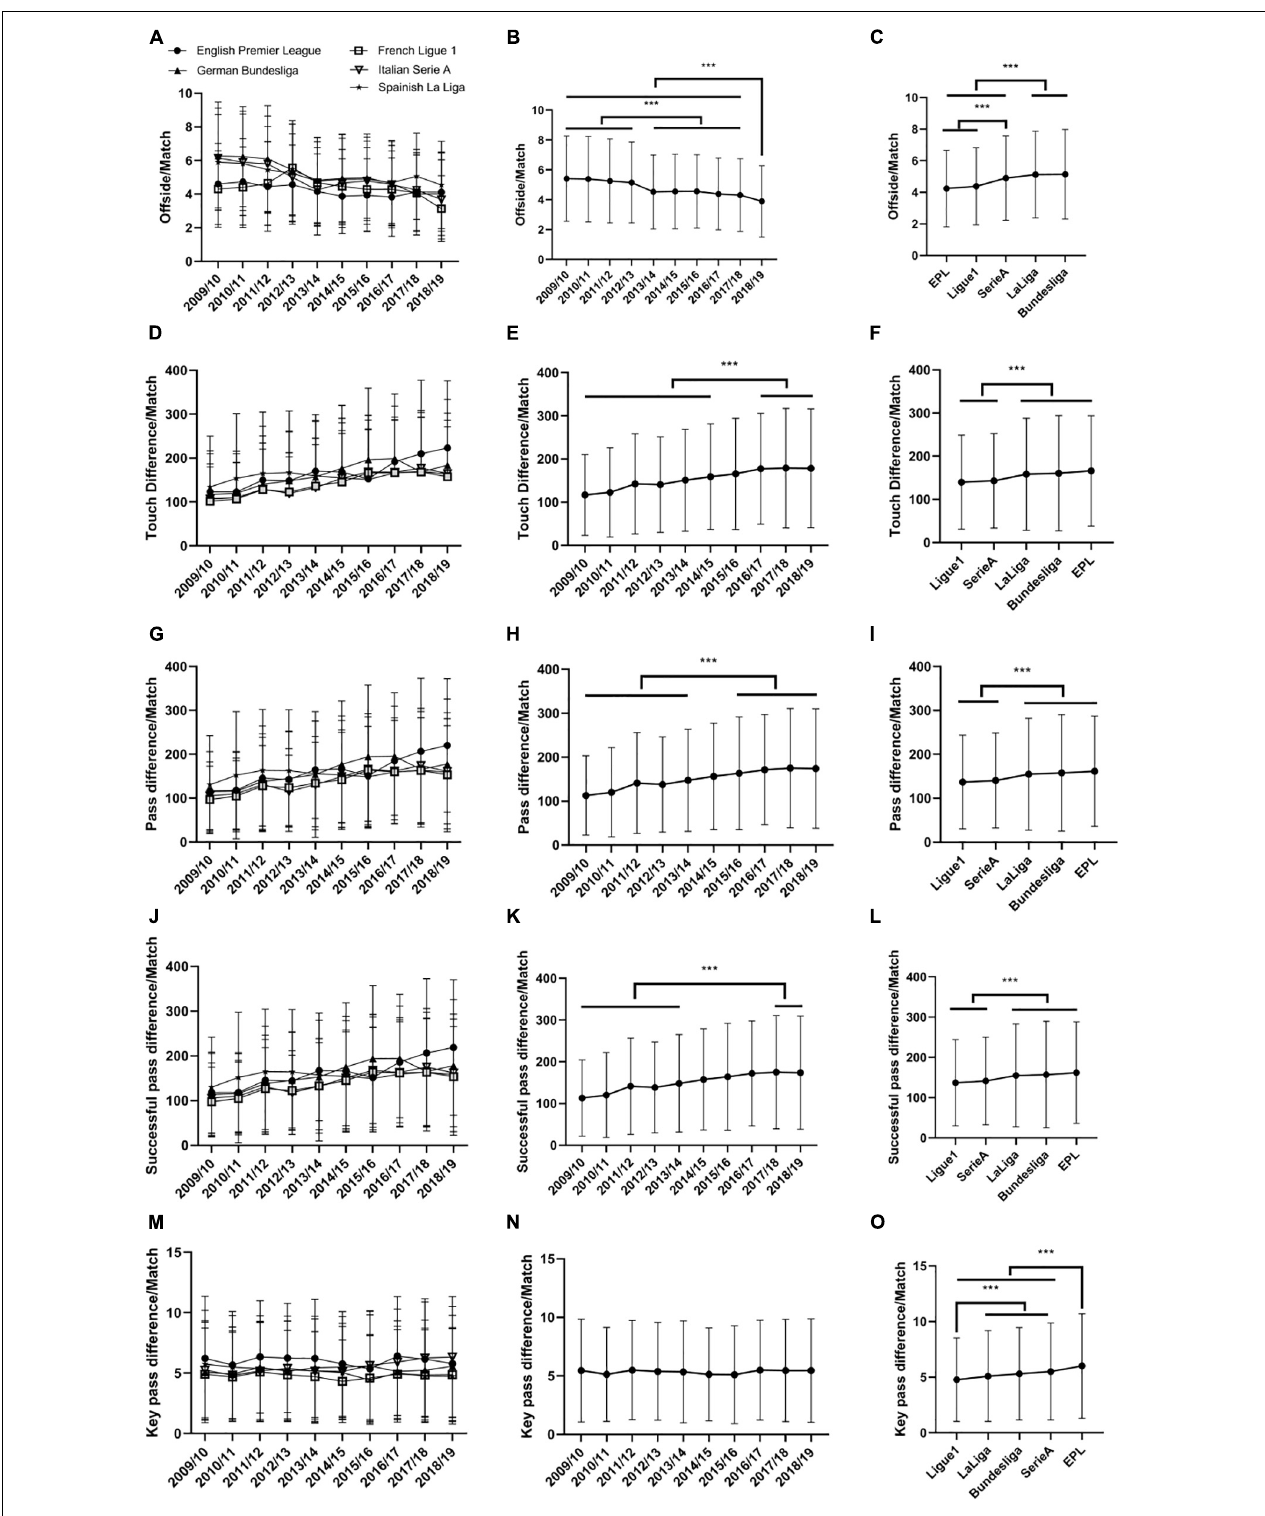
FIGURE 2 | (A) Offsides per match, (D) touch difference per match, (G) pass difference per match, (J) successful pass difference per match, (M) and key pass difference per match for each league over the ten seasons span. (B) Offsides per match, (E) touch difference per match, (H) pass difference per match, (K) successful pass difference per match, (N) and key pass difference per match for each season. (C) Offsides per match, (F) touch difference per match, (I) pass difference per match, (L) successful pass difference per match, (O) and key pass difference per match for each league. Data are shown as mean ± SD. ***Denotes statistical significance at the 0.1%